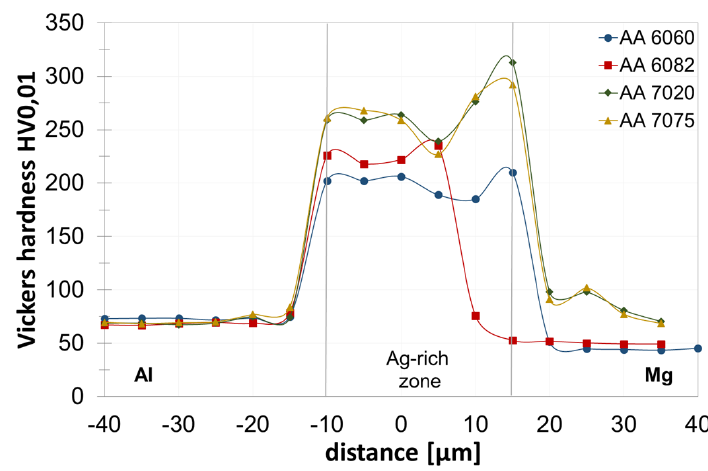
Figure 9. Hardness profiles across the interface of the diffusion-bonded Al-Mg joints with silver interlayer.